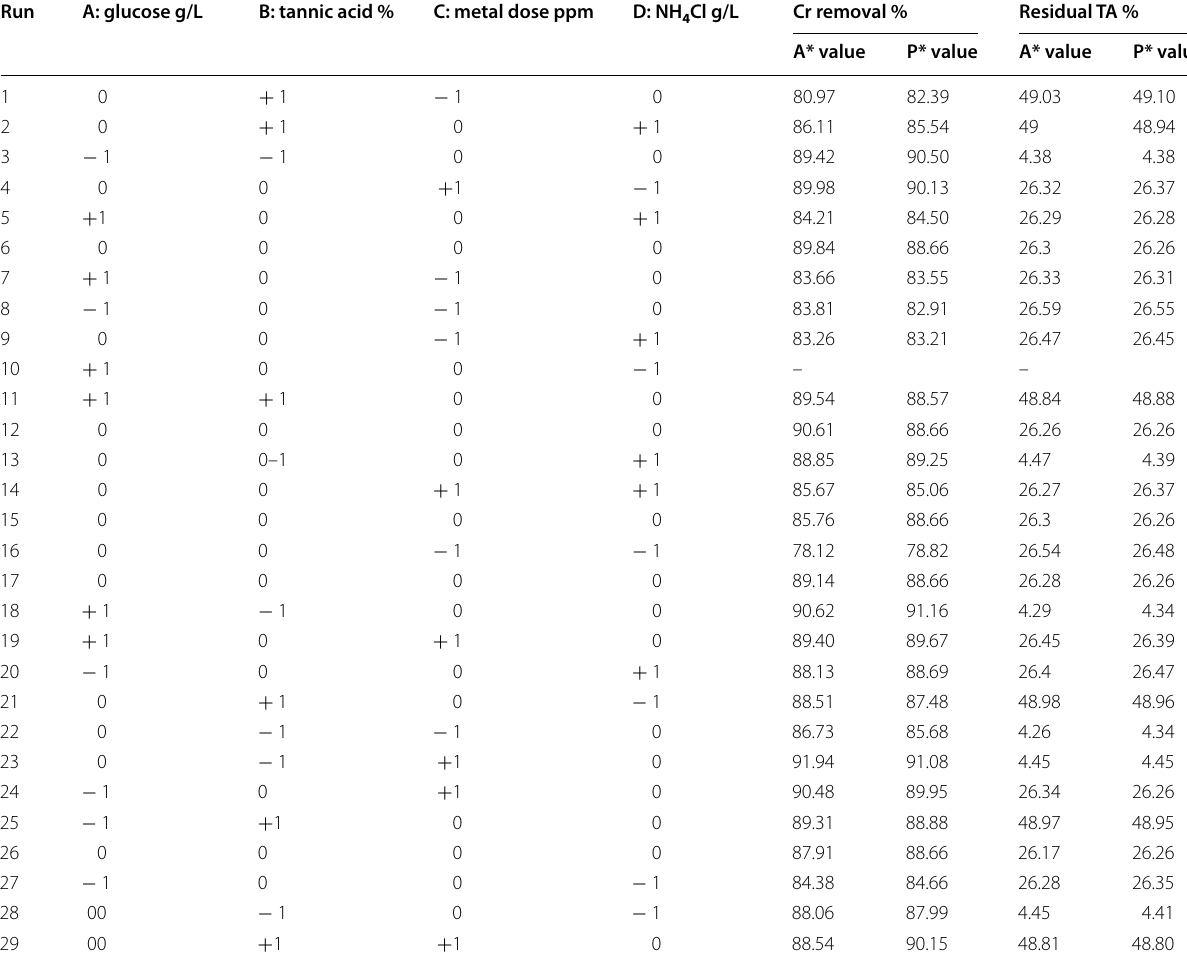
Table 3 Box–Behnken experimental design of A. niveus